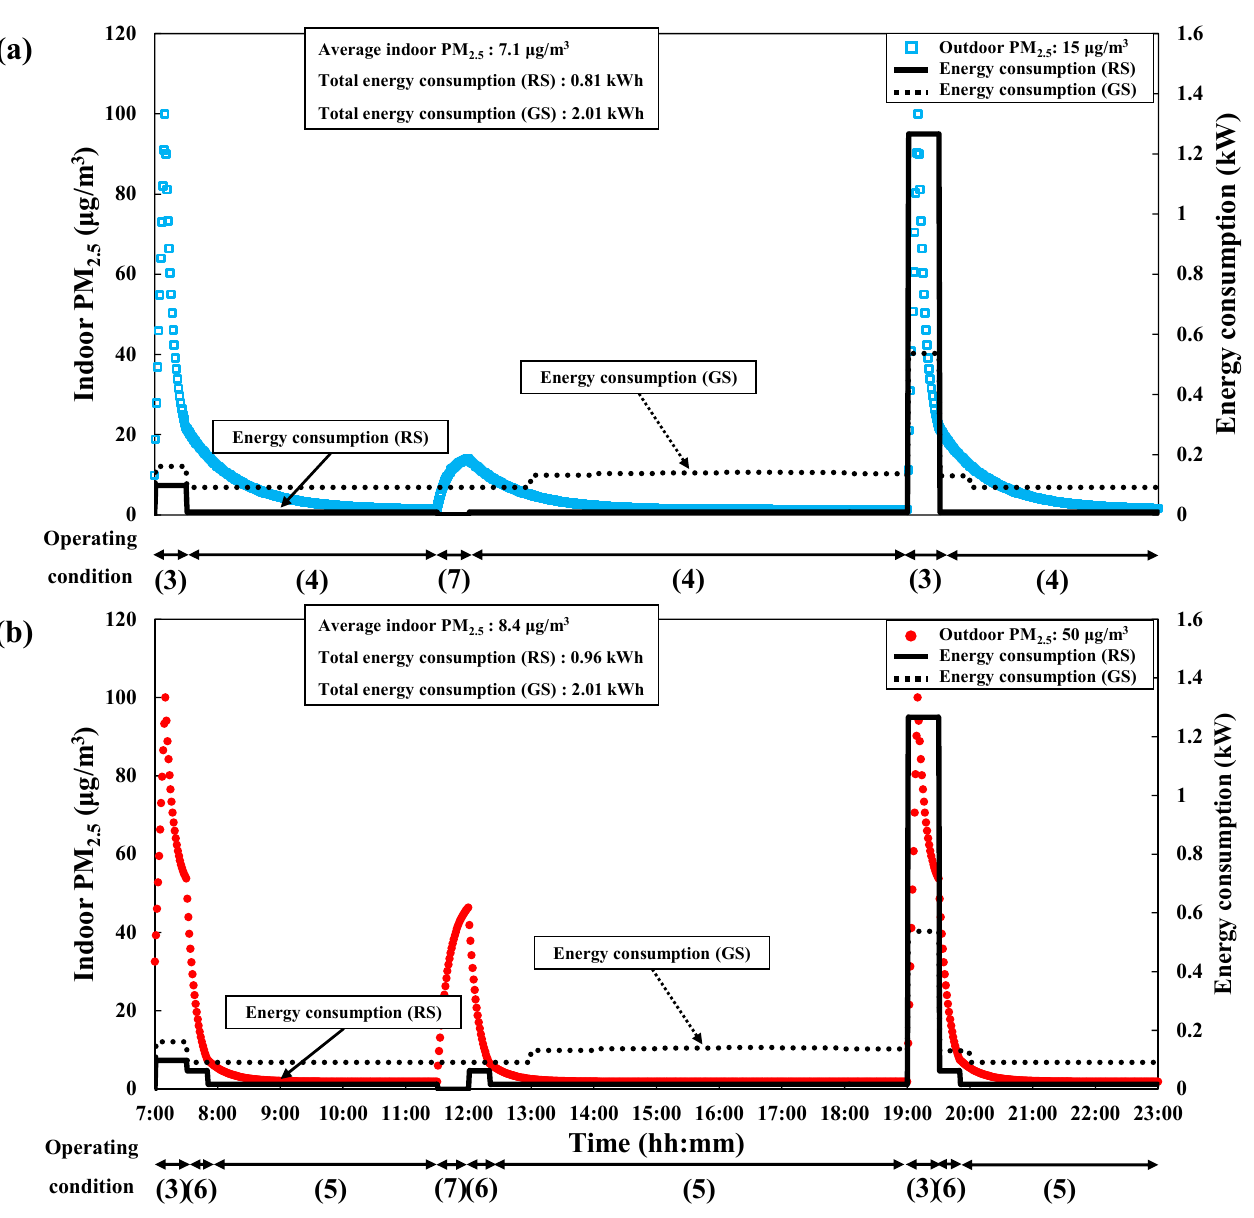
Figure 6. Changes in PM 2.5 concentration and energy consumption with time to maintain average PM 2.5 <10 μ g/m 3 under the energy consumption reduction scenario in summer (GS: general scenario, RS: reduction scenario). ( a ) Outdoor PM 2.5 : 15 μ g/m 3 . ( b ) Outdoor PM 2.5 : 50 μ g/m 3 . Table 5. Timetable of IAQ management operating conditions for the energy consumption reduction scenario in spring/autumn and summer (NV: natural ventilation, MV: mechanical ventilation, RH: range hood, and AP: air purifier).